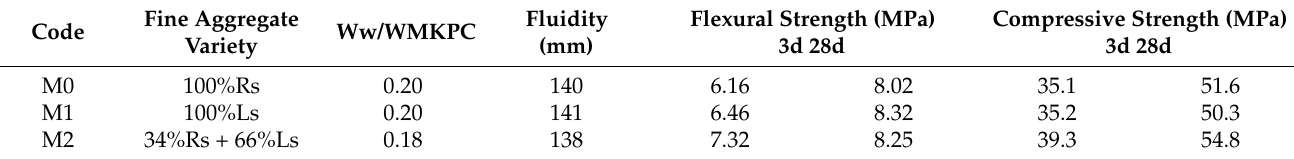
Table 2. Some mechanical properties of MKPC